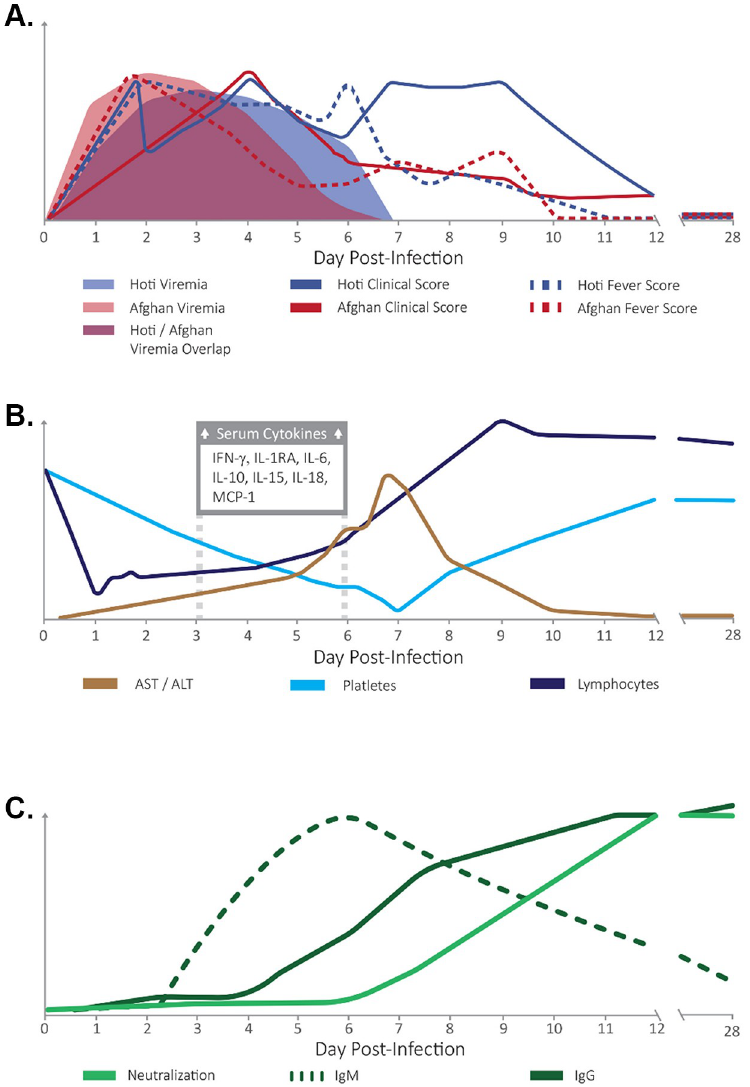
Fig 6. Comparative summary of the disease progression in cynomolgus macaques infected intravenously with CCHFV strain Hoti or Afg09. A) Comparison of fever and clinical score for both strains in comparison to viremia over time. B) Progression of AST/ALT, hematology, and serum cytokine levels over time. C) Development of neutralizing antibody and anti-nucleocapsid IgM and IgG in response to CCHFV infection over time. Due to their nearly identical kinetics, all parameters displayed in B) and C) are shown as merged averages between strains and represent “generic” CCHFV responses. These figures are intended to be qualitative and are only meant to convey relative trends over